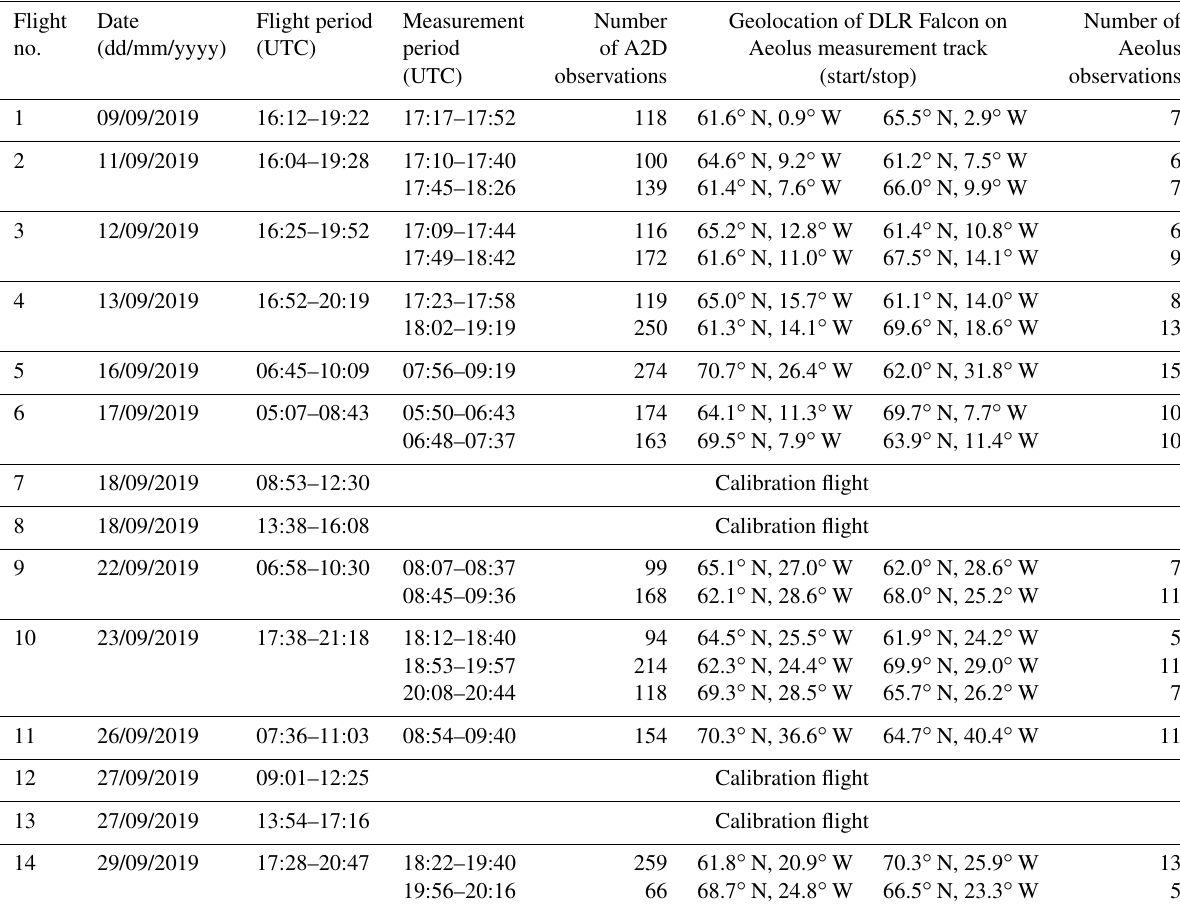
Table 2. Overview of the research flights of the Falcon aircraft in the frame of the AVATARI campaign in September 2019 and the wind scenes performed with the A2D along the Aeolus measurement